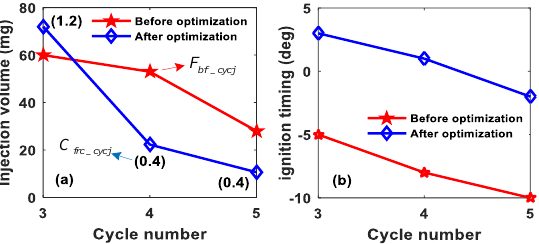
Figure 14. Optimization results of injection volume and ignition timing: ( a ) injection volume; ( b ) ignition timing.